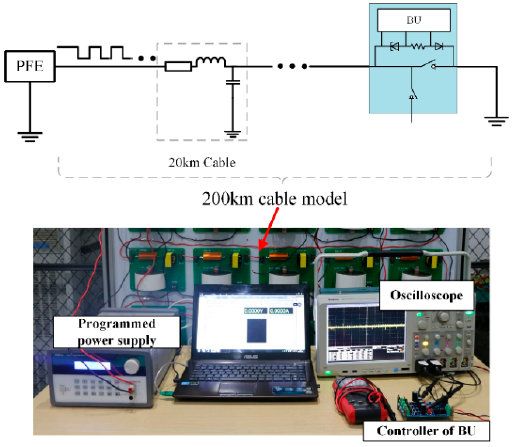
Figure 16. Experiment of fault isolation.